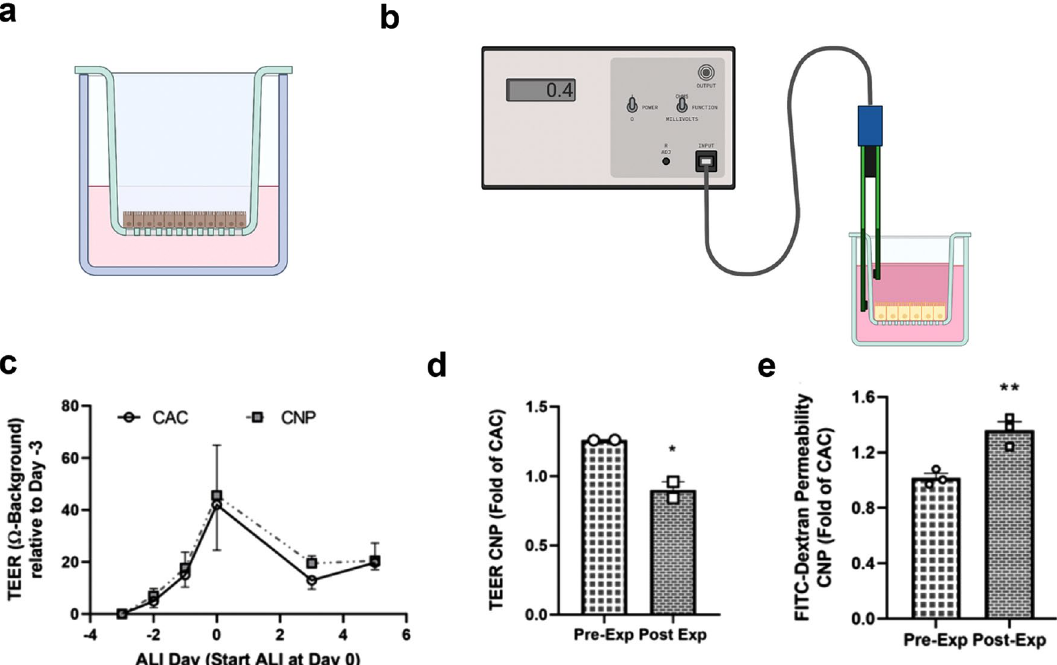
Figure 2. Assessment of barrier integrity in ALI-cultured 16HBE14o- cells pre- and post-exposure. ( a ) Schematic representation of ALI-cultured 16HBE14o- cells ( b ) Schematic representation of a TEER device is depicted ( c , d ) TEER was measured as described in the method section before and after ALI start until day 5 (pre-exposure) and expressed relative to TEER values at day -3. Data are mean ± SEM of four independent experiments with three Transwell inserts for each experiment. Each Transwell insert was measured at three cavities and the mean was recordedb TEER was measured directly before (pre-exposure) and after (post- exposure) 4-h CNP or CAC exposure and expressed relative to TEER values at day -3. Data are mean ± SEM of two or three independent experiments with three Transwell inserts for each experiment. ( e ) FITC-Dextran permeability was measured one day before (pre-exposure) and directly after (post-exposure) CNP or CAC exposure. Data are mean ± SEM of three independent experiments with three Transwell inserts for each experiment. Two-tailed, unpaired student ‘s t-test; * p < 0.05; ** p <